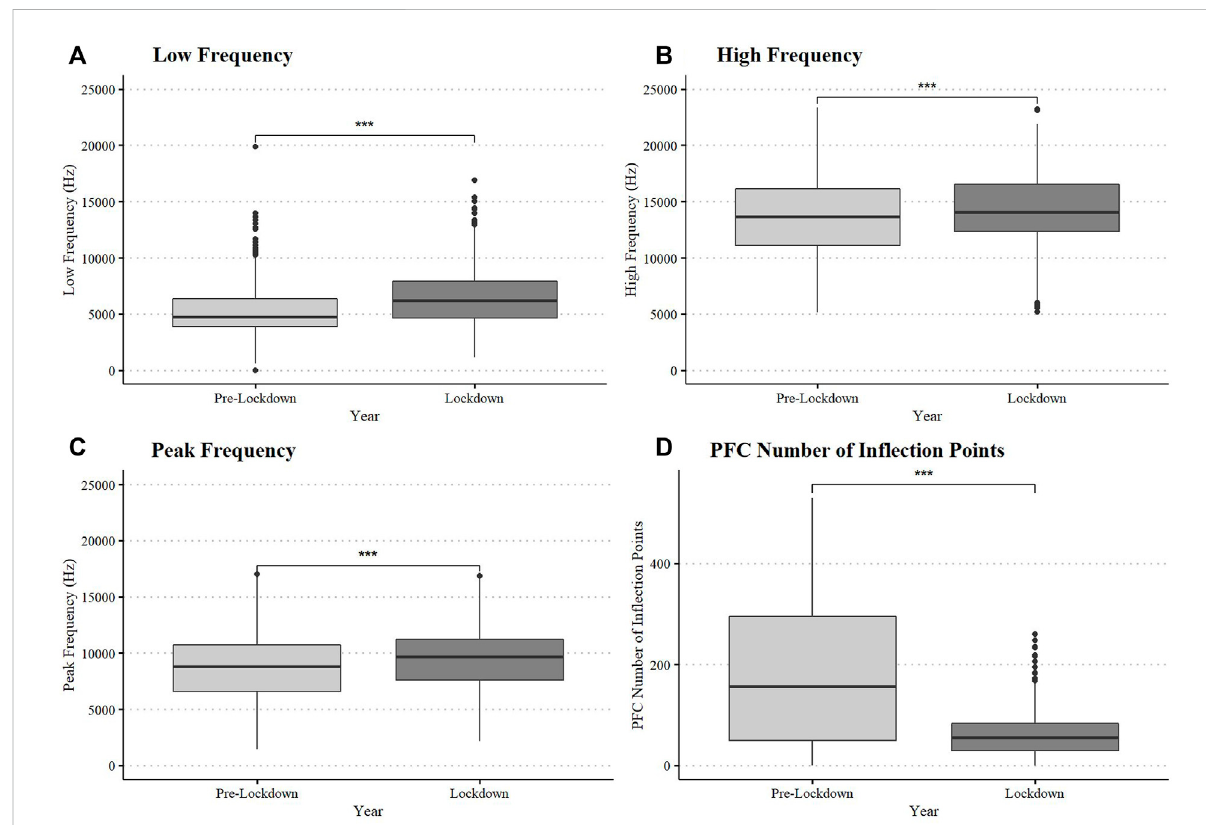
FIGURE 3 Dolphin whistle frequency and modulation variation between pre-lockdown and lockdown. Box plots display medians, fi rst and third quartiles, aswellasstandarderror(A=LowFrequency, B=HighFrequency,C=PeakFrequency, andD=ModulationmeasuredasPFCNumberofIn fl uection Points).